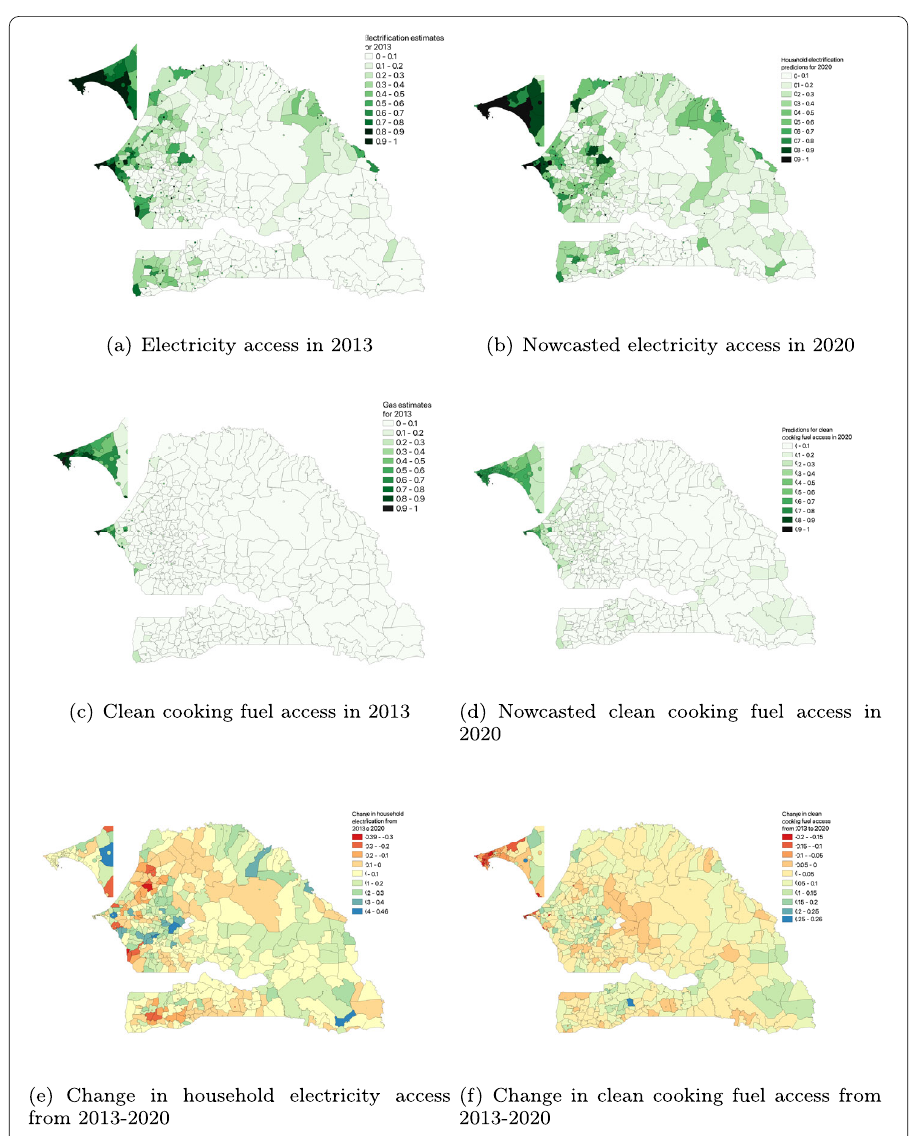
Figure 2 Quantifying the evolution of household energy access from 2013 to 2020 for 552 communes in Senegal. ( a ) Electricity access in 2013 using census ( b ) Nowcasted electricity access in 2020 ( c ) Clean cooking fuel access in 2013 using census ( d ) Nowcasted clean cooking fuel access in 2020 ( e ) Changes in household electricity access from 2013 to 2020. ( e ) Changes in household clean cooking fuel access from 2013 to 2020. Administratively, Senegal is organized into 14 regions and 45 departments. The finest level of policy planning is communes. From the 2013 census, it has 384 rural communes and 168 urban communes (which includes 121 urban centers). Dakar region is shown enlarged in the inset. Urban centers are shown as dots on the